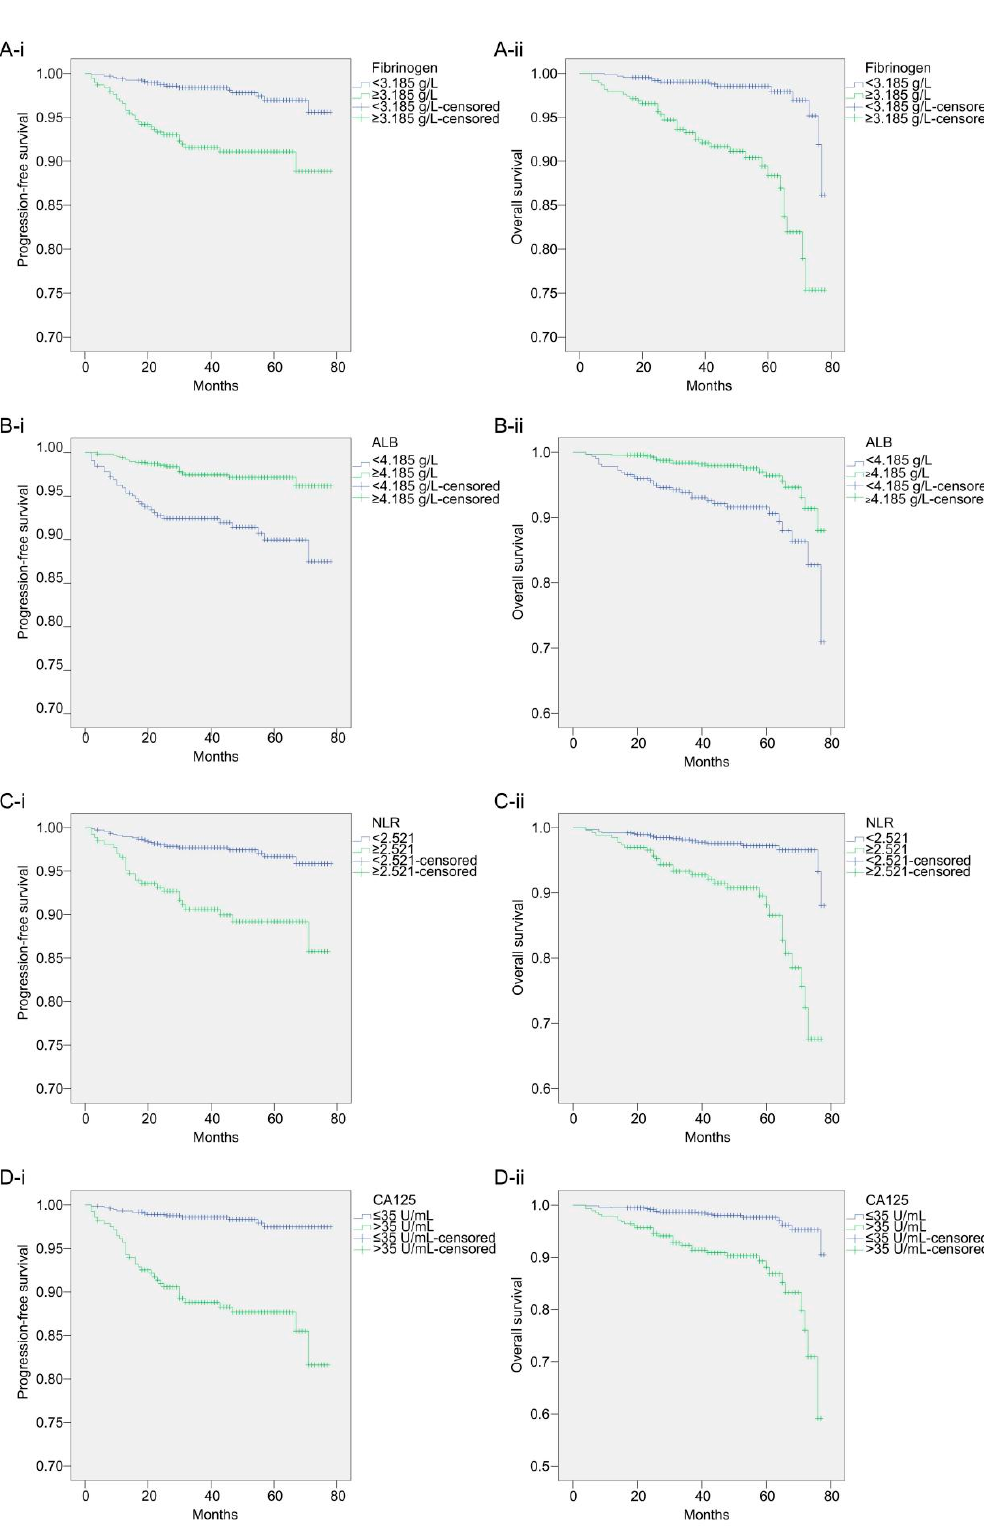
Figure 2. The survival curves for each biomarker level group. ( A-i ): Kaplan–Meier curves of PFS for each fibrinogen level group; ( A-ii ): Kaplan–Meier curves of OS for each fibrinogen level group; ( B-i ): Kaplan–Meier curves of PFS for each ALB level group; ( B-ii ): Kaplan–Meier curves of OS for each ALB level group; ( C-i ): Kaplan–Meier curves of PFS for each NLR level group; ( C-ii ): Kaplan–Meier curves of OS for each NLR level group; ( D-i ): Kaplan–Meier curves of PFS for each CA125 level group; ( D-ii ): Kaplan–Meier curves of OS for each CA125 level